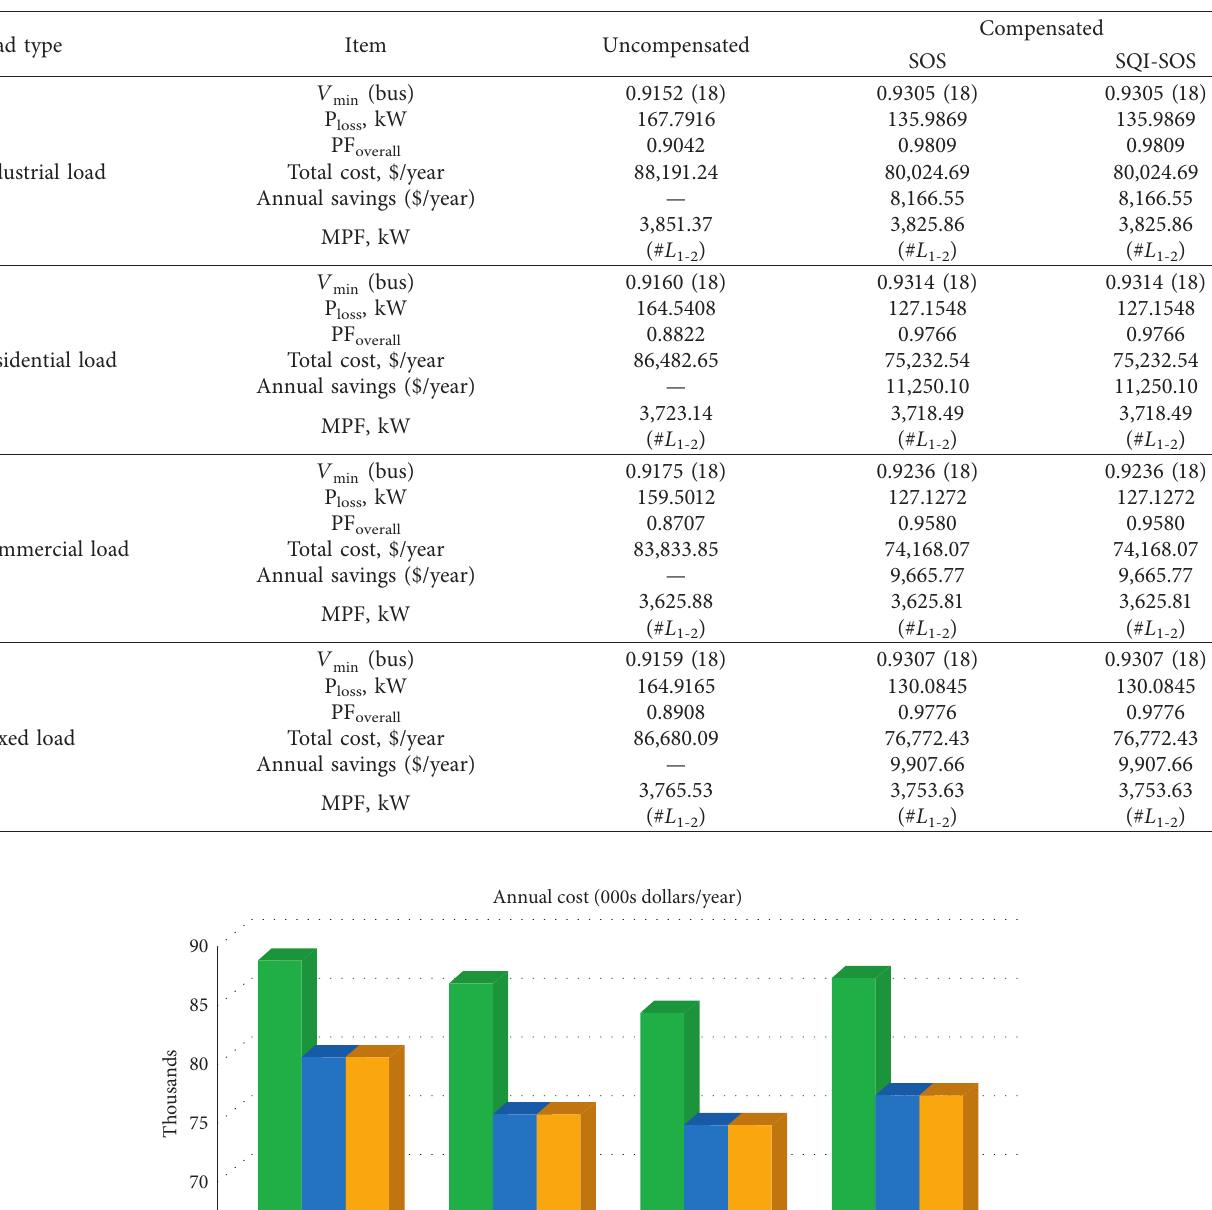
Table 7: Comparative results of the 33-bus system after compensation with different load models.